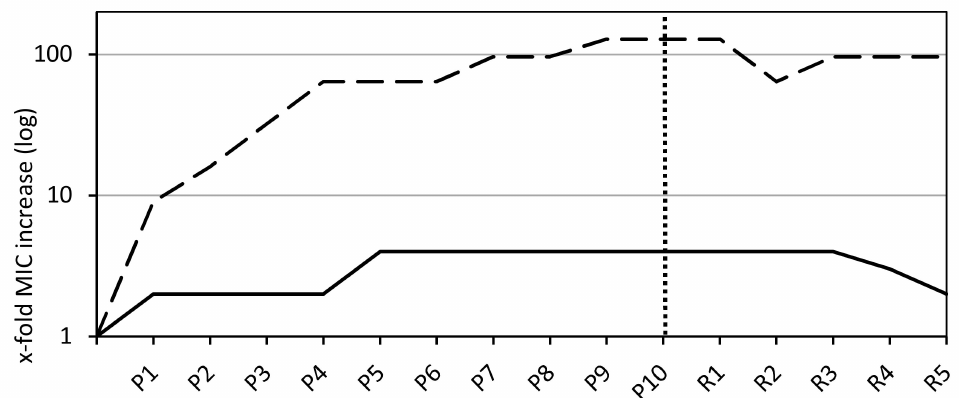
Figure 1. Minimal inhibitory concentration (MIC) values as a median of all tested S. aureus isolates for sodium bituminosulfonate (n = 30) and fusidic acid (n = 6, dashed line). The dotted vertical line indicates the endpoint after 10 passages on linear gradient plates containing the active agents (labeled with P) and recovery passages on plain agar plates (labeled with